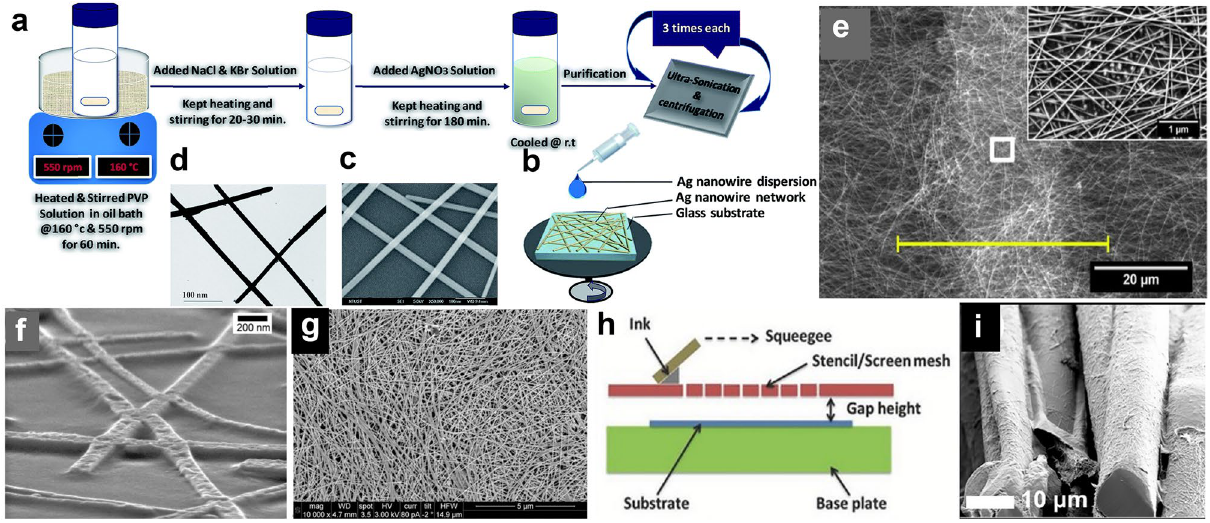
Fig. 5 Fabrication process and structures for AgNWs in different fields. a Schematic diagram of synthesis and purification of AgNWs with hydrothermal method. b Schematic diagram of spin-coated AgNWs network on a glass substrate. c SEM image of the spin-coated AgNWs net- work on a glass substrate. d TEM image of the spin-coated AgNWs network on a lacey carbon-coated copper grid. Reproduced with permission [135]. Copyright (2017), Royal Society of Chemistry. e Close ‐ up of fused AgNWs junctions embedded into polymethyl-methacrylate (PMMA). Reproduced with permission [148]. Copyright (2013), Wiley–VCH. f SEM image of the interconnection with enlarged interconnection region. Inset showing the contact between AgNWs and ITO. Reproduced with permission [151]. Copyright (2015), Wiley–VCH. g Cross-sectional illus- tration of the screen ‐ printing process, and h SEM image of the dense AgNWs network structure in the screen ‐ printed AgNWs line for intrinsi- cally stretchable AgNWs TFT array. Reproduced with permission [156]. Copyright (2016), Wiley–VCH. i SEM images of individual filaments, which used as a Joule heating element for woven heating fabric. Reproduced with permission [157]. Copyright (2020), American